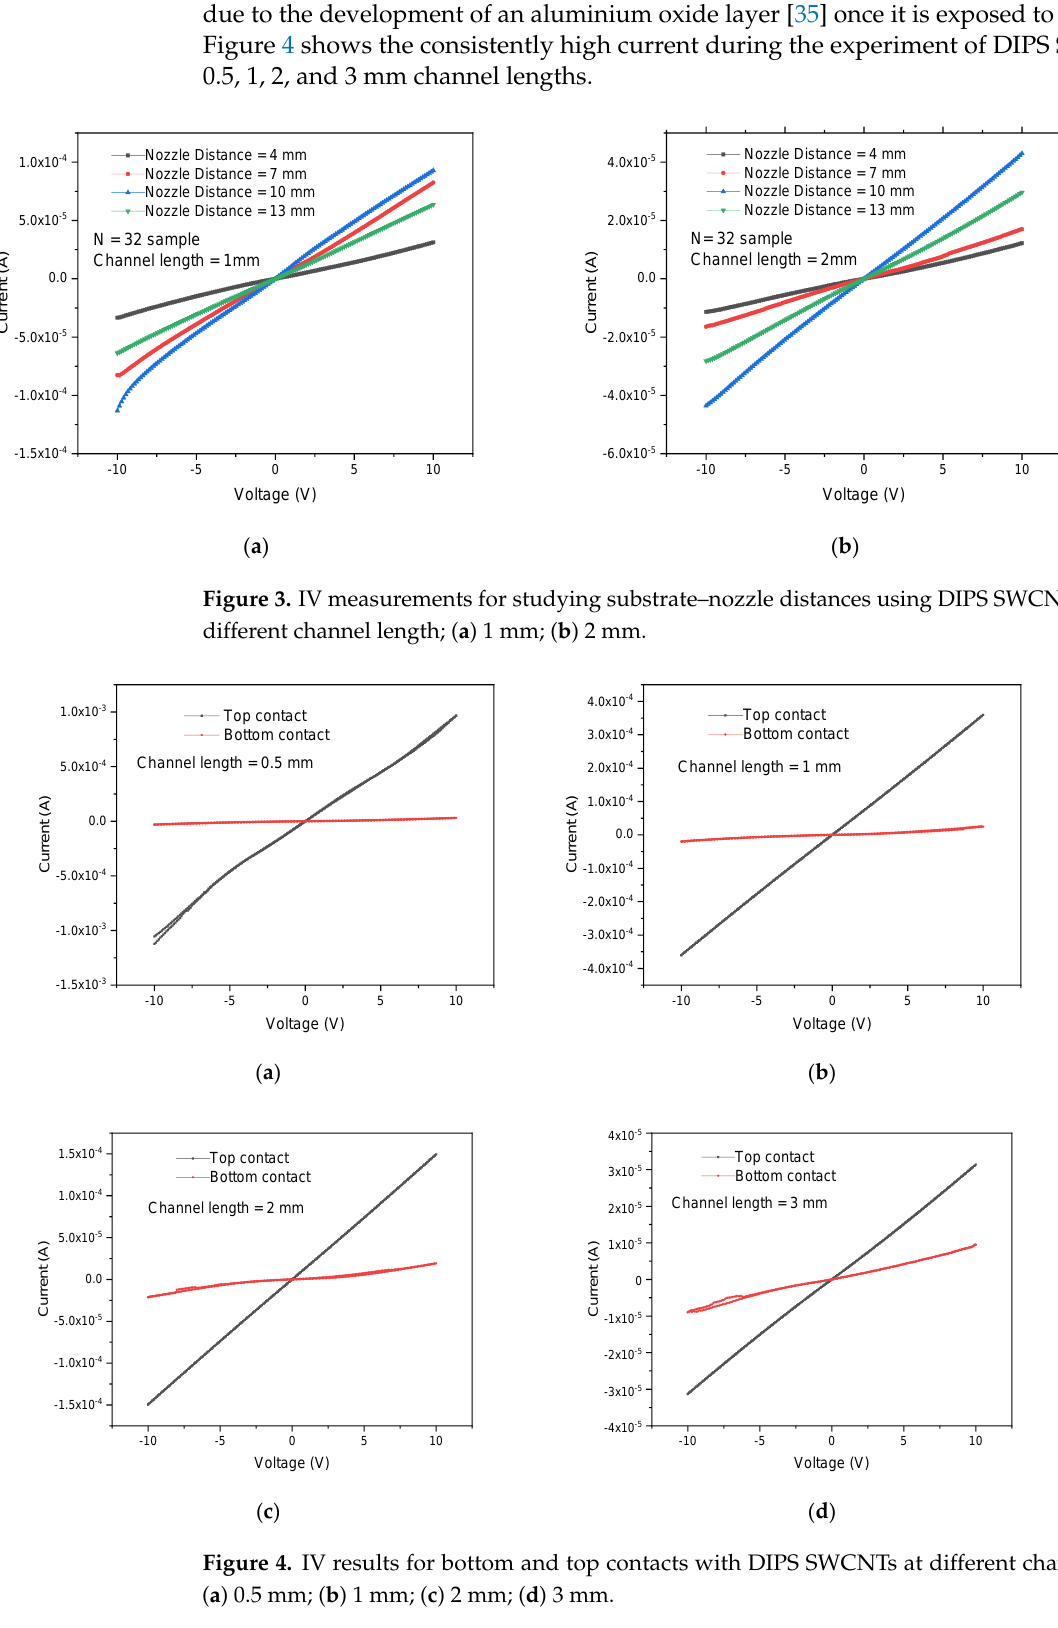
mm to 3 mm channel lengths, which is relevant according to Equation (2). This indicates that the shortest channel length is the most suitable setting for this device. Resistivity, ρ = RA/L; A = W × h ;